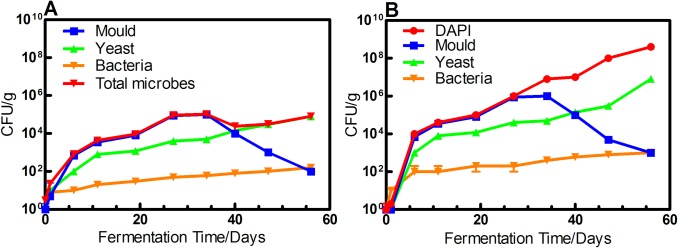
The number of microorganism during the fermentation of the pile of Xiaguan Tuo Tea.(A)analysis of the number of microorganisms by dilution plating method. (B)analysis of the number of microorganisms by FISH.